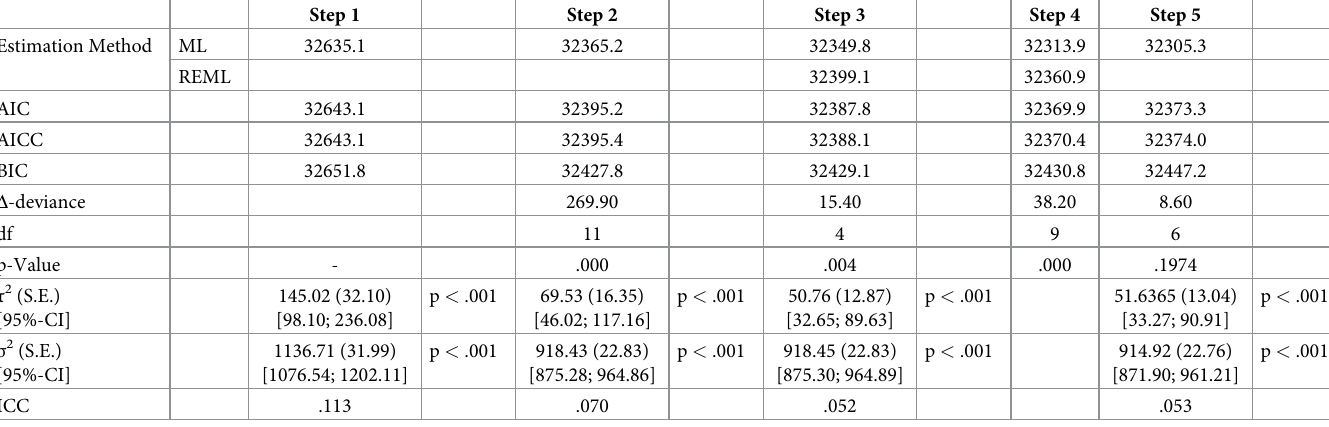
Table 5. Model information table including a display of information criteria, deviance test results and estimated variance components for every model building step including fixed slopes.